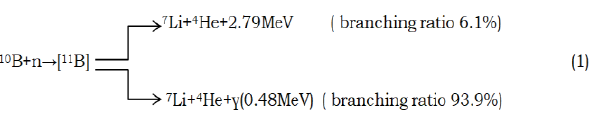
Fig. 1. Boron-containing compounds (BCCs). The fundamental core structures for BCCs